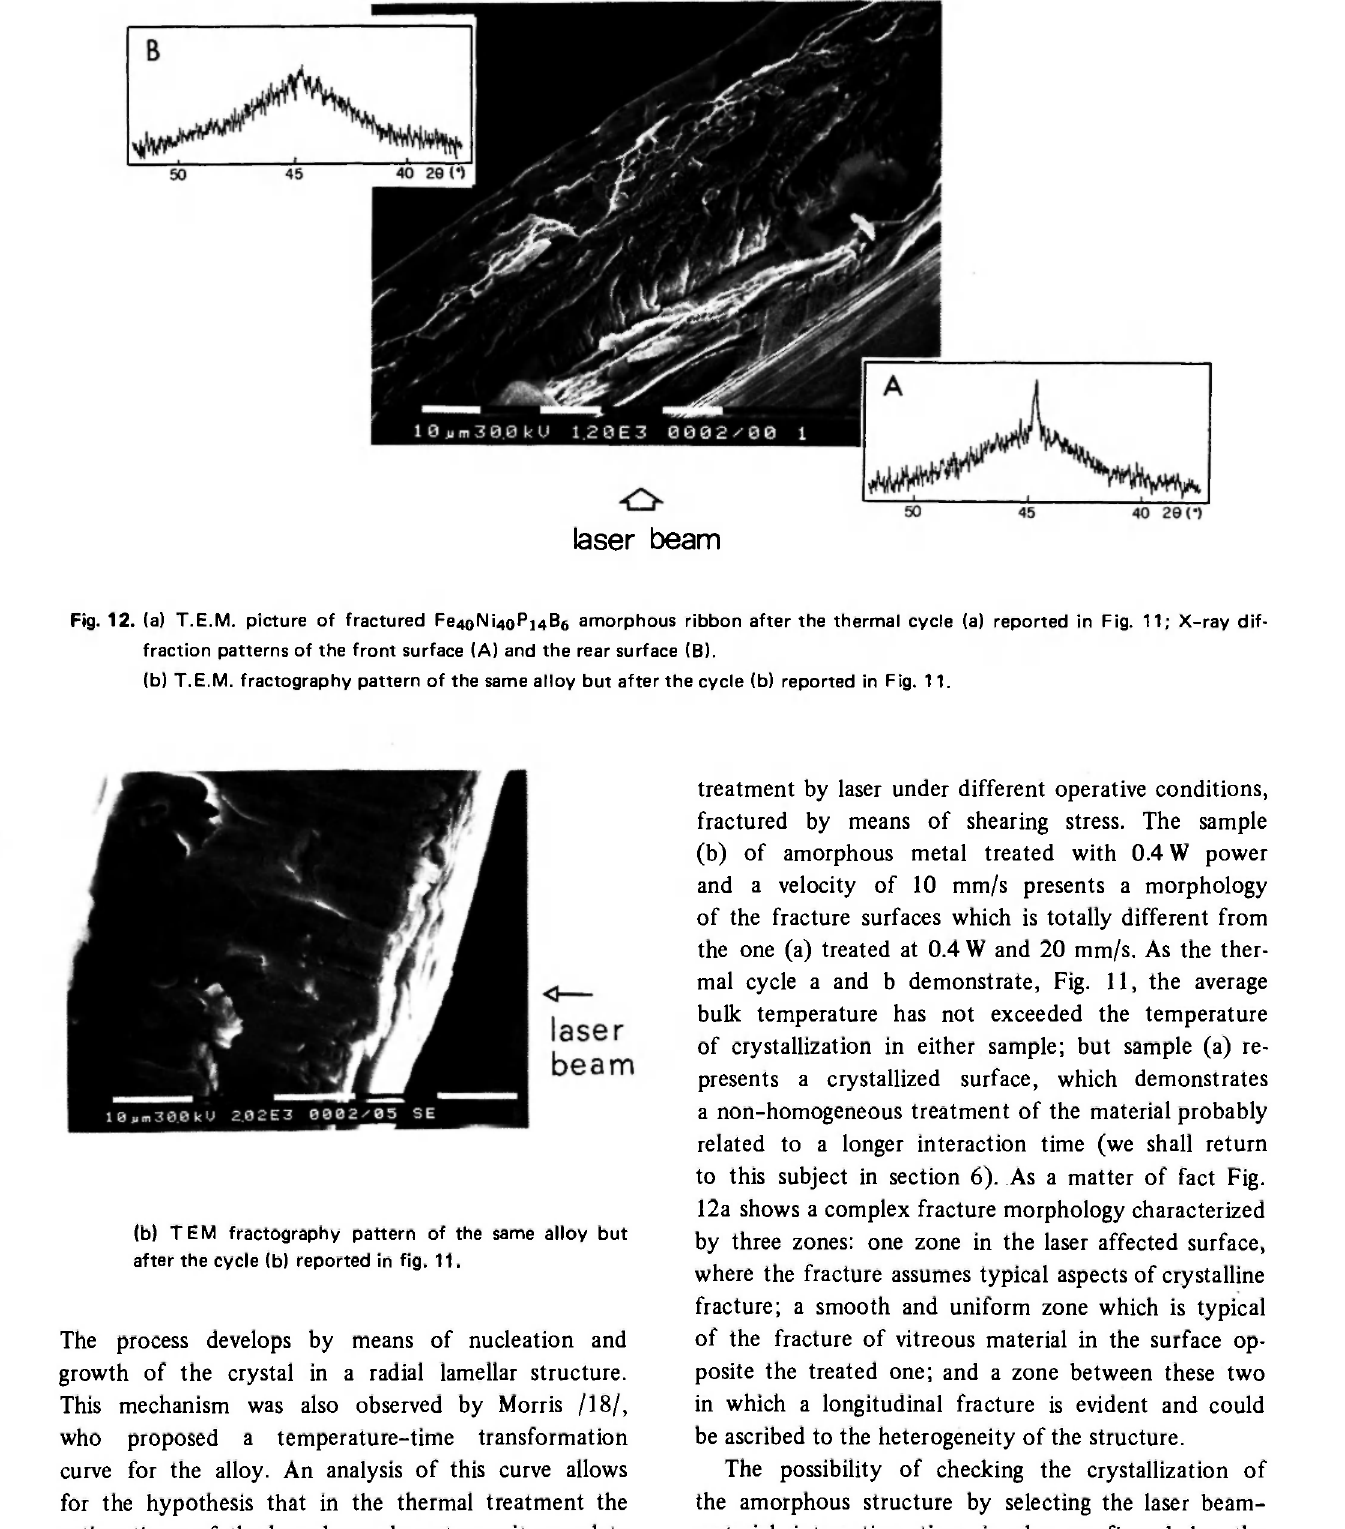
(b) T EM fractography pattern of the same alloy